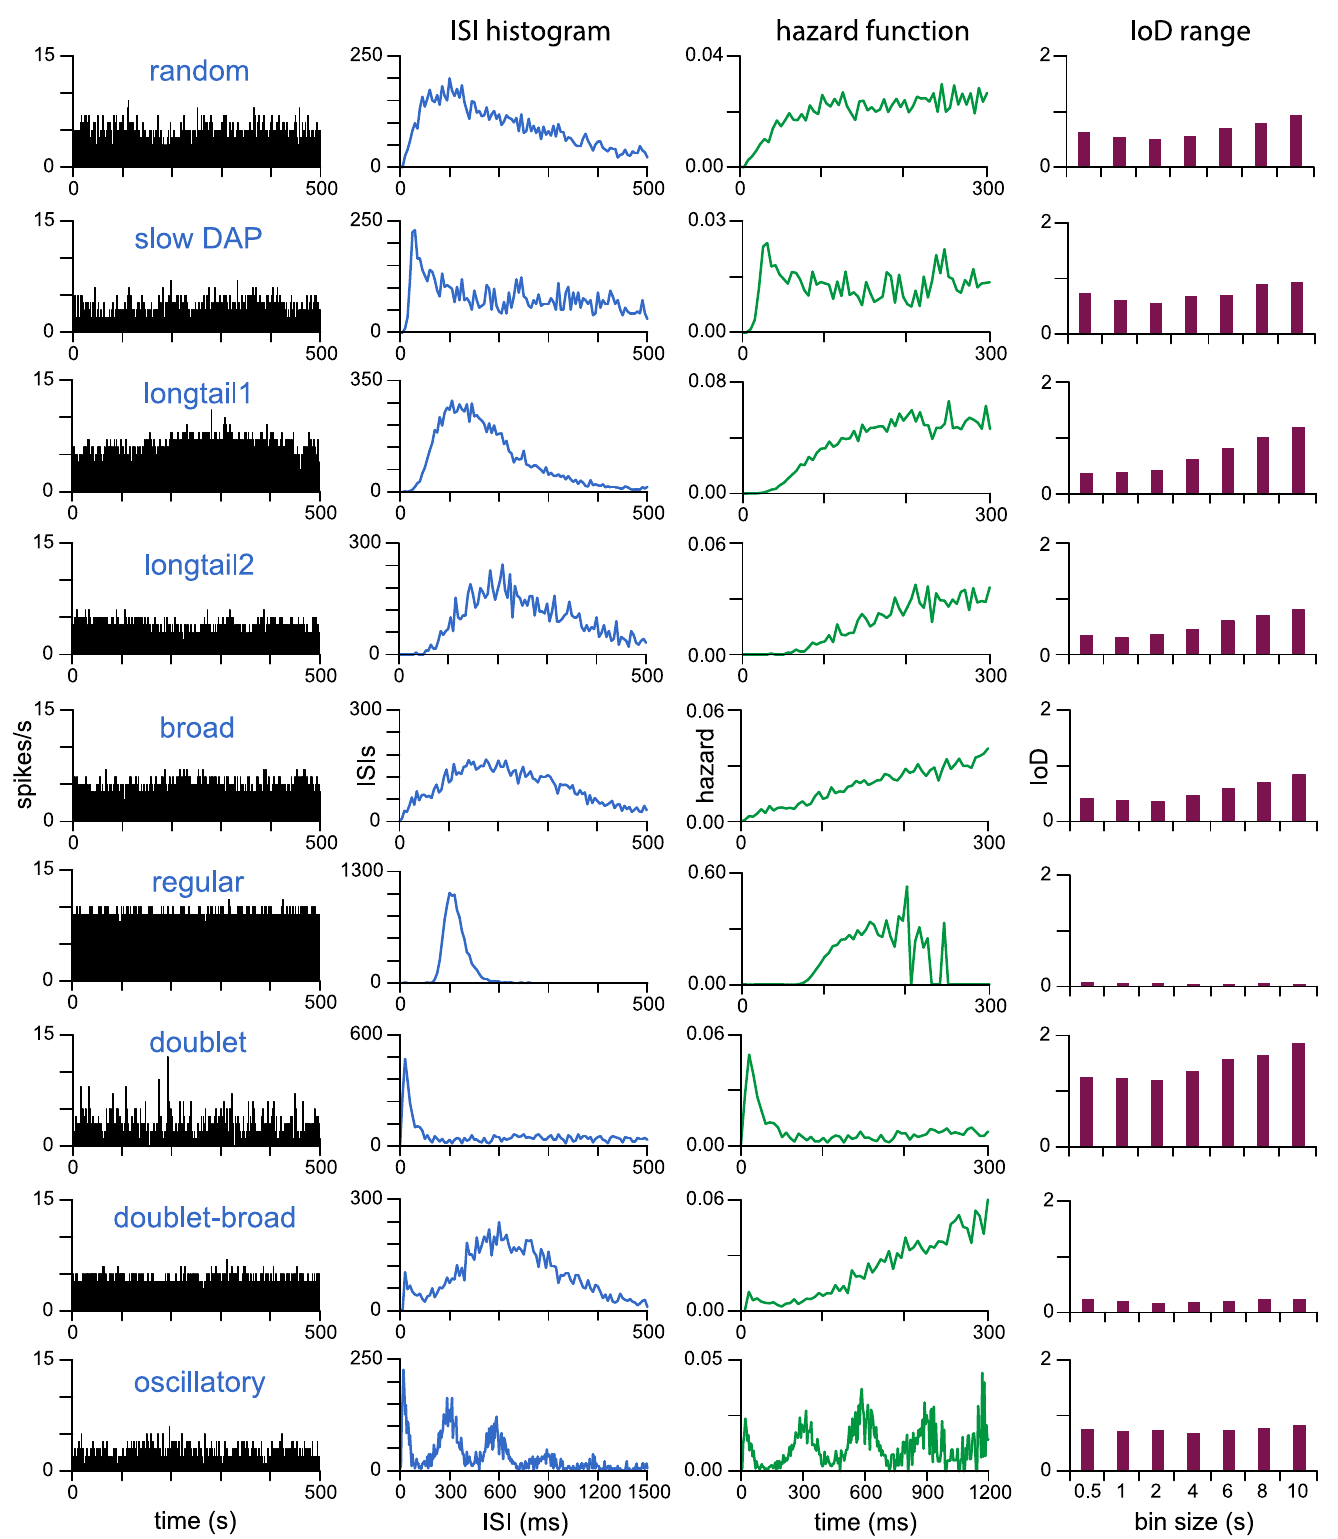
Fig 1. Neural subtypes in the VMN identified by spike patterning. Typical examples of each cell type previously identified [20] from 271 in vivo extracellular recordings of the VMN. The left column shows extracts of firing rate in 1-s bins, to the right of these are the corresponding ISI distribution constructed in 10-ms bins